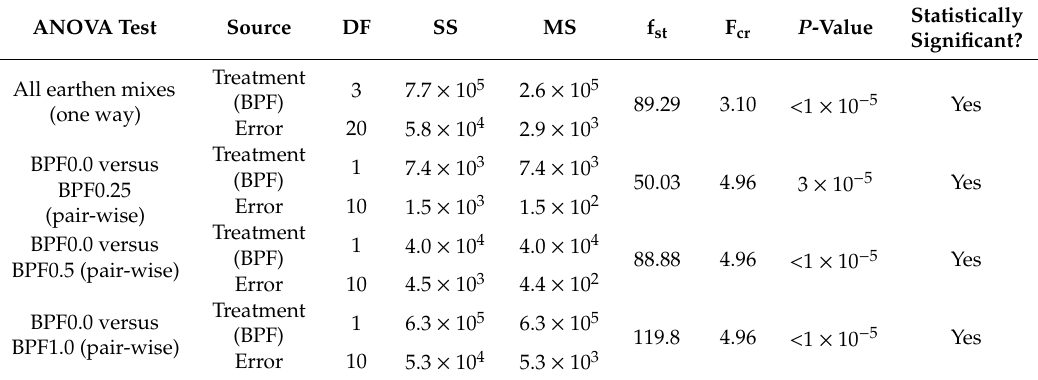
Table 9. 5% significance level ANOVA tests for the impact strength at the collapse of earthen mixes.